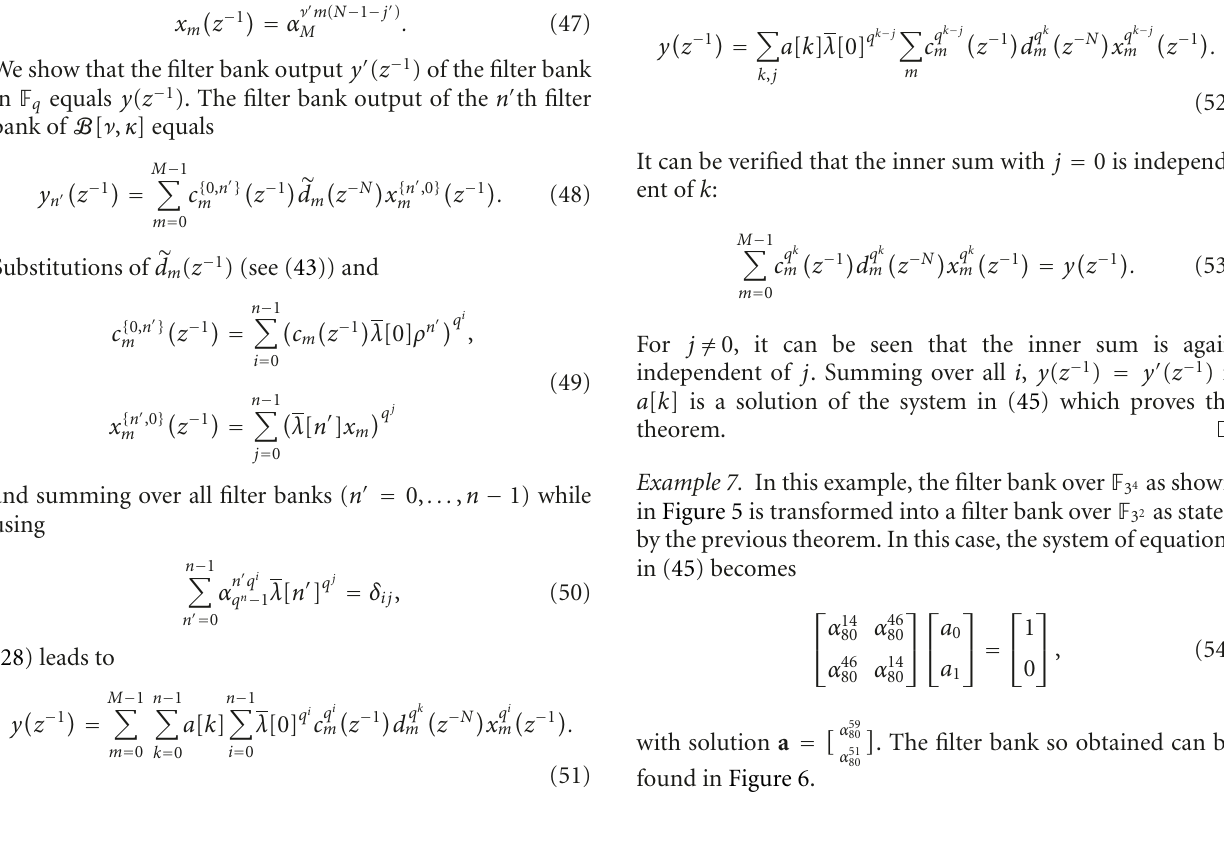
(cid:3) (cid:4) = α ν (cid:6) m ( N − 1 − j (cid:6) ) z − 1 x m M